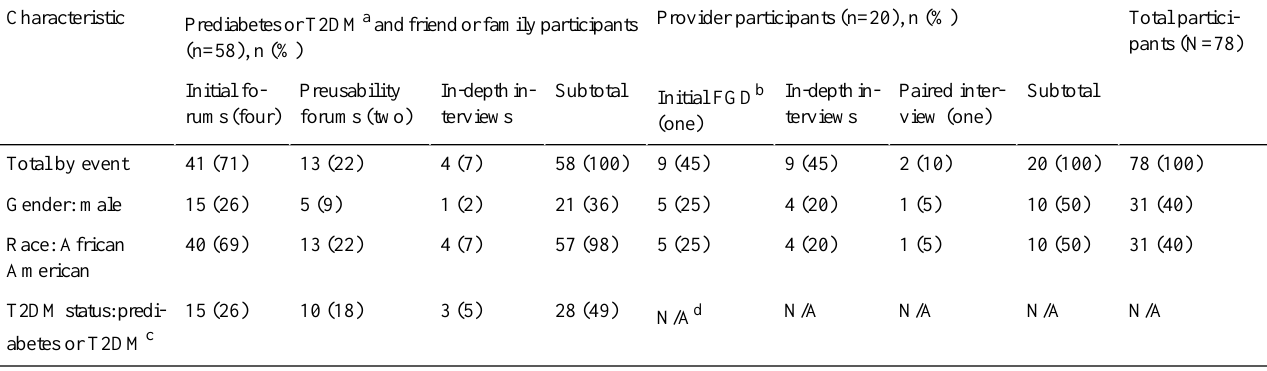
Table 1. Participant characteristics and data collection events.